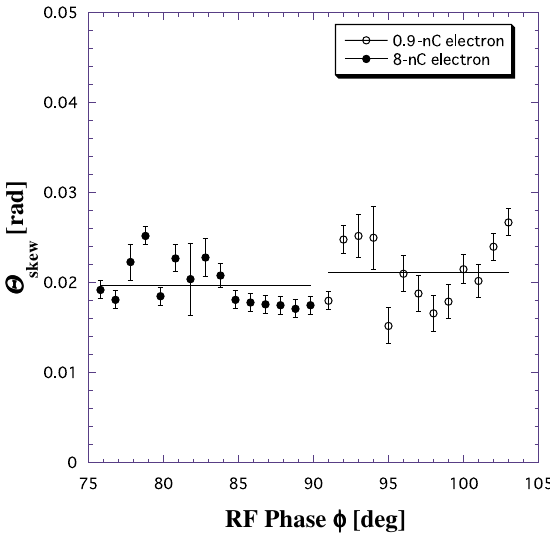
FIG. 8. (Color) Variations of the skew angles depending on the rf phase of the booster klystron obtained for the 0.9 and 8-nC electron beams. The solid lines show the average skew angles over the measured rf region.